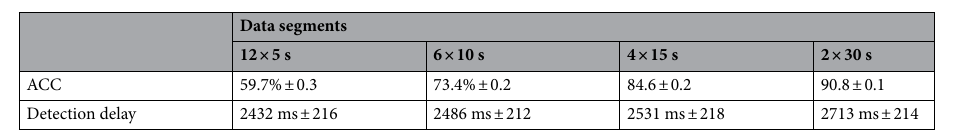
Table 4. The classification performance of the proposed SAAD system with DQL (RNN agent) (in terms of detection delay and ACC) in attention switching scenarios obtained for different data segments and 100 repetitions of the